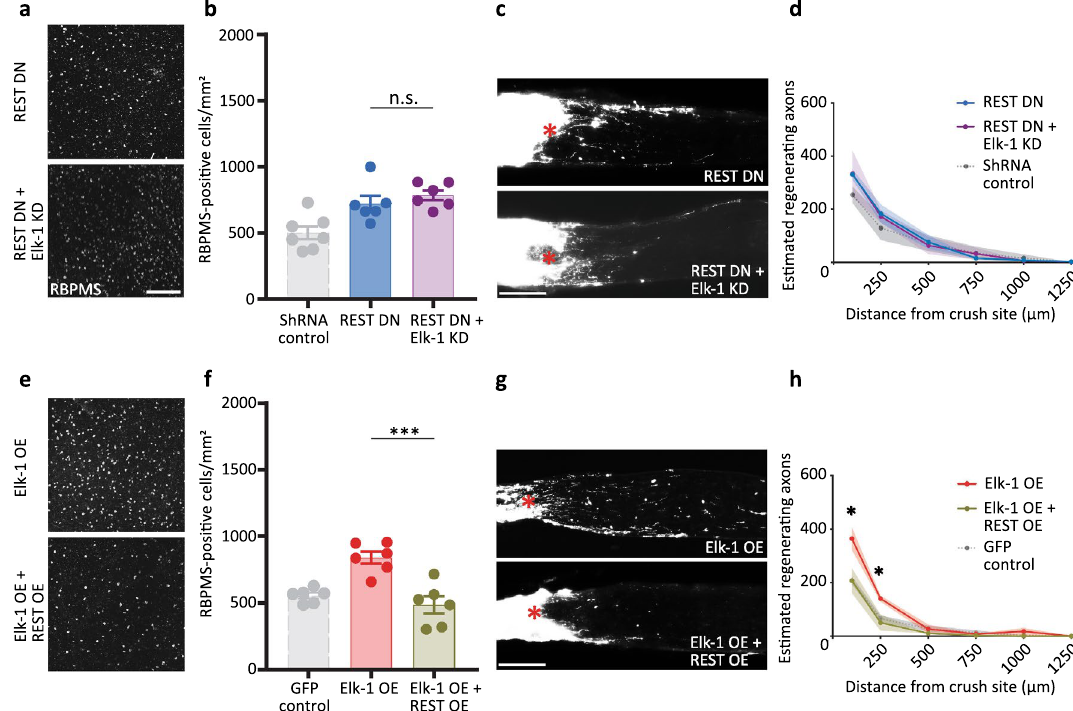
Figure 5. Elk-1 interacts with REST in regulating RGC neuroprotection and axon regeneration. ( a ) Representative images show RBPMS staining of RGCs at day 14 after optic nerve crush, for either AAV2- DN-REST + AAV2-shRNA-Luciferase or AAV2-DN-REST + AAV2-shRNA-Elk-1 injected WT mice. ( b ) Quantitative analysis of RBPMS-positive cell number in the retinas in ( a ). n = 6 per group, two-tailed Student’s t-test. For reference, the data of the shRNA control group in Fig. 2e are shown in light gray. ( c ) Representative images of the optic nerve sections showing CTB-labelled regenerating axons at day 14 after optic nerve injury, for either AAV2-DN-REST + AAV2-shRNA-Luciferase or AAV2-DN-REST + AAV2-shRNA-Elk-1 injected WT mice. ( d ) Quantitative analyses of estimated regenerating axons from the injury site in the optic nerves in ( c ). n = 4 (REST DN) and n = 5 (REST DN + Elk-1 KD), multiple t-tests. For reference, the data of the shRNA control group in Fig. 2-g are shown in light gray. ( e ) Images show RBPMS staining of RGCs at day 14 after optic nerve crush, for either AAV2-Elk-1 + AAV2-GFP or AAV2-Elk-1 + AAV2-REST injected WT mice. ( f ) Quantitative analysis of RBPMS-positive cell number in the retinas in e . n = 6 per group, *** P < 0.001, two-tailed Student’s t-test. For reference, the data of the GFP control group in Fig. 2i are shown in light gray. ( g ) Images of the optic nerve sections showing CTB-labelled regenerating axons at day 14 after optic nerve injury, for either AAV2- Elk-1 + AAV2-GFP or AAV2-Elk-1 + AAV2-REST injected WT mice. ( h ) Quantitative analyses of estimated regenerating axons from the injury site in the optic nerves in ( g ). n = 5 (Elk-1 OE) and n = 4 (Elk-1 OE + REST OE), * P < 0.05, multiple t-tests. For reference, the data of the GFP control group in Fig. 2k are shown in light gray. n.s., not significant. Asterisks, lesion sites. Scale bars, 200 µm. The data are presented as means ±